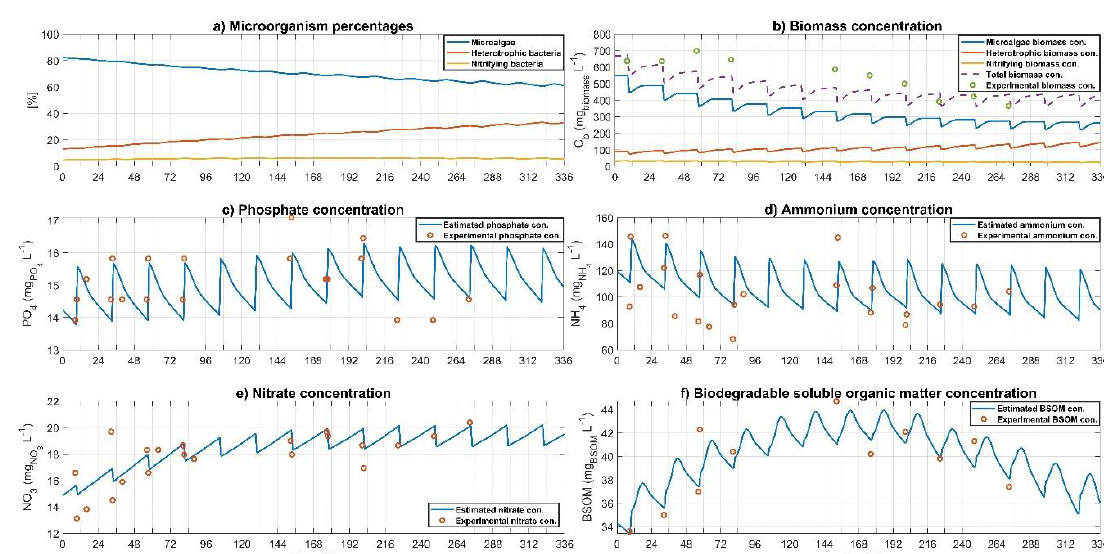
Figure 5. Calibration results for the biomass production model with wastewater medium. ( a ) Microalgae and bacteria percentages inside the reactor; ( b ) Microalgae and bacteria biomass concentration; ( c ) Phosphate concentration inside the reactor; ( d ) Ammonium concentration inside the reactor; ( e ) Nitrate concentration inside the reactor; ( f ) Biodegradable soluble organic matter concentration inside the reactor.